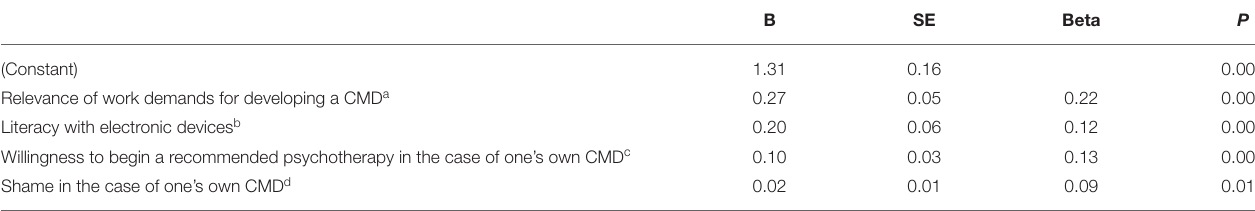
TABLE 2 | Predictors for the attributed relevance of using mental health applications as a prevention strategy for CMDs (mean score).